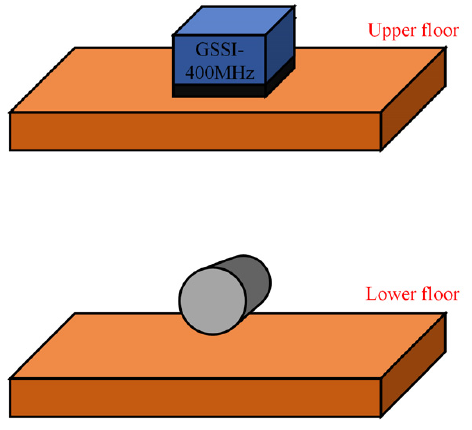
Figure 4. The simulation scenario.